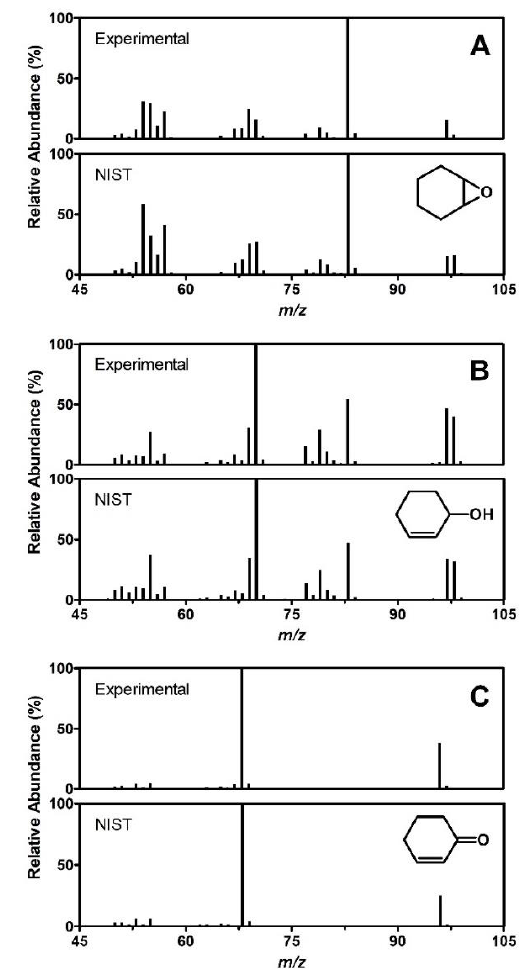
Figure 4. Comparison of the mass spectra of products obtained from oxofunctionalization of cyclohexene under visible light irradiation with the mass spectra of epoxycyclohexane, 2-cyclohexen-1-ol, and 2-cyclohexen-1-one reported in the National Institute of Standards and Technology (NIST)